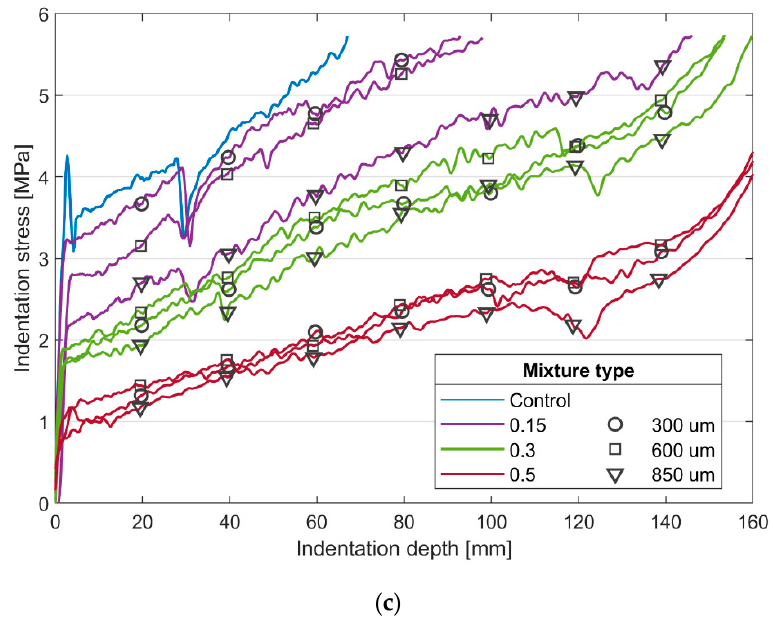
Figure 3. Loading responses of all the samples at ( a ) 7, ( b ) 14, and ( c ) 21 days.